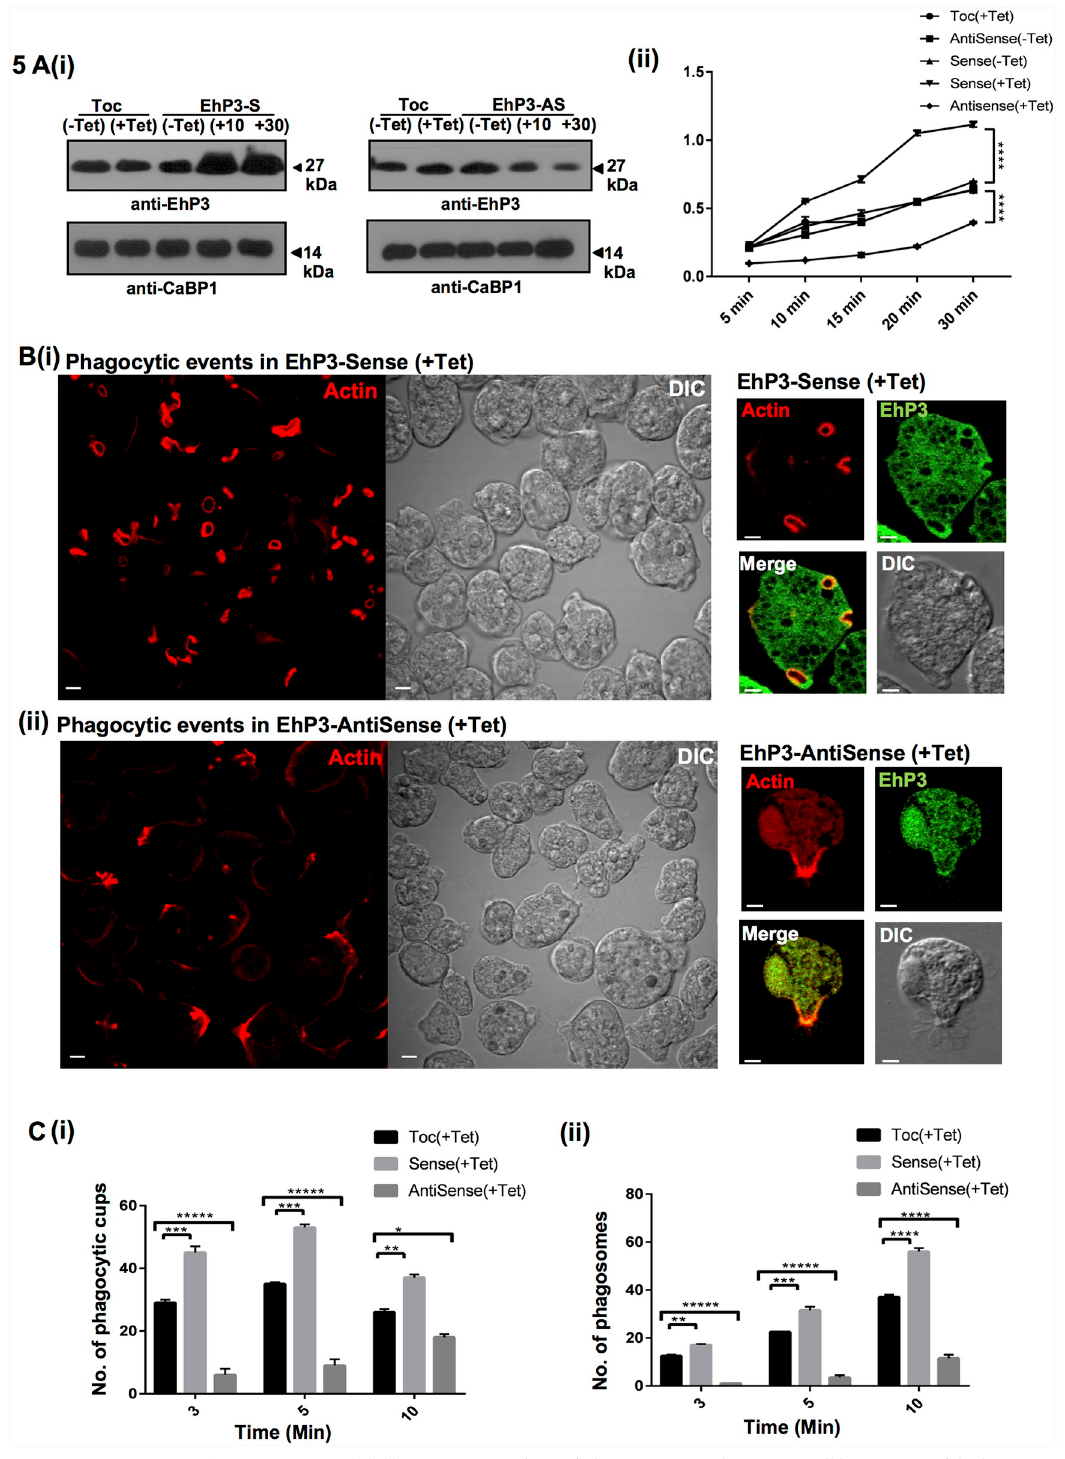
Fig 5. EhP3 is essential for phagocytosis. (A) (i) Expression analysis of EhP3 in sense and antisense cell lines. 50 μ g of the lysate prepared from E . histolytica cells expressing either Tet-O-CAT (TOC) vector alone, antisense EhP3 (AS) or sense EhP3 (S) gene grown in presence and absence of tetracycline (10, 30 μ g/ml) were loaded in respective lanes. The lanes were probed with anti-EhP3 antibody for expression analysis and anti-EhCaBP1 antibody was taken as equal loading control. (ii) Erythrocyte uptake assay